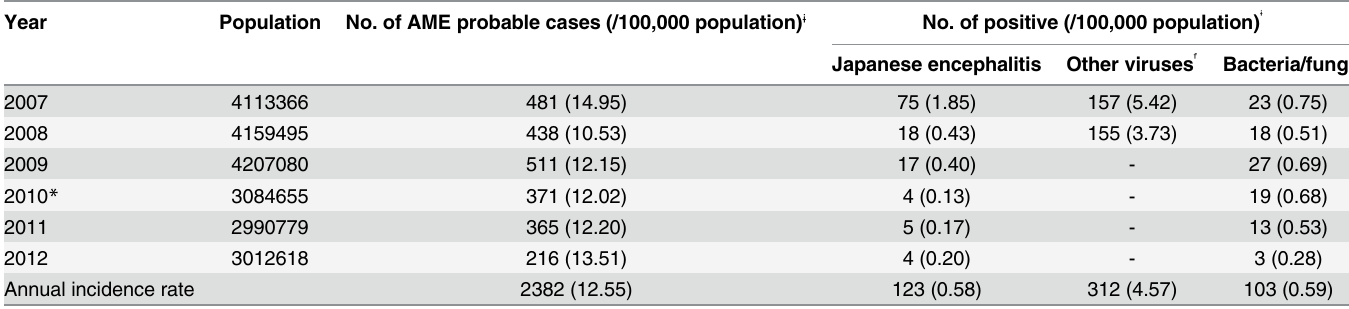
Table 1. Yearly incidence rate of acute meningitis and encephalitis (AME) in Guigang City, Guangxi, May 2007- June 2012. Year